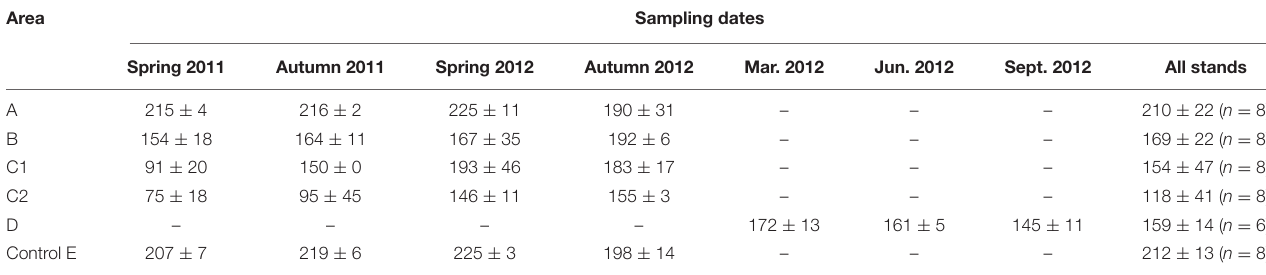
TABLE 3 | Average QBS-values and standard deviation obtained during seasonally and annual monitoring ( n = number of samples/year).